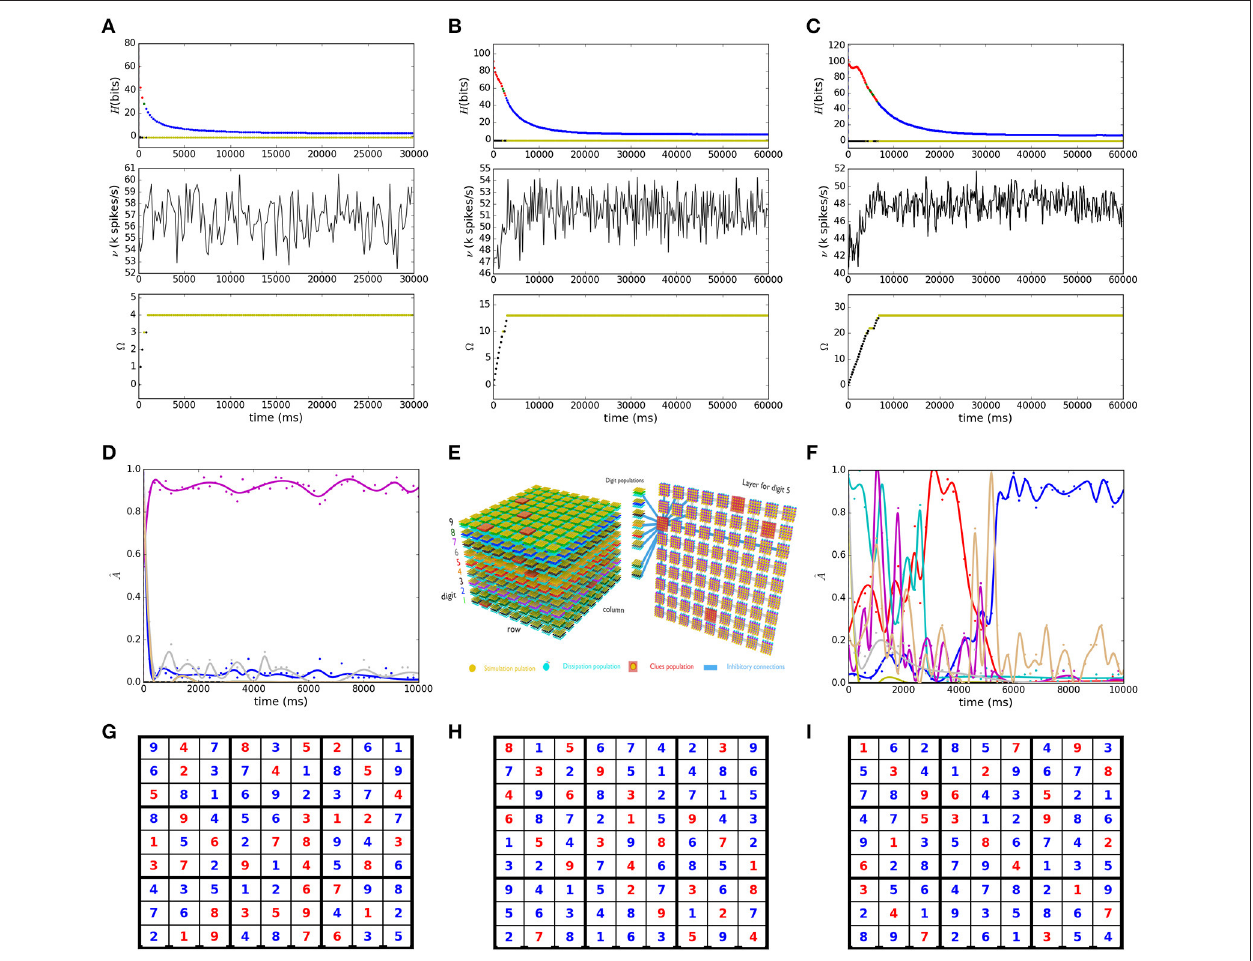
FIGURE 2 | Spiking neural network solution to Sudoku puzzles. (A–C) Show the temporal dependence of the network entropy H , firing rate ν and states count (cid:127) for the easy (G) , hard (H) , and AI escargot (I) puzzles. The color code is the same as that of Figure 1 . In (G–I) red is used for clues and blue for digits found by the solver. (D,F) Illustrate the activity for a random selected cell from (A,C) , respectively, evidencing competition between the digits, the lines correspond to a smoothing spline fit. (E) Schematic representation of the network architecture for the puzzle in (A)